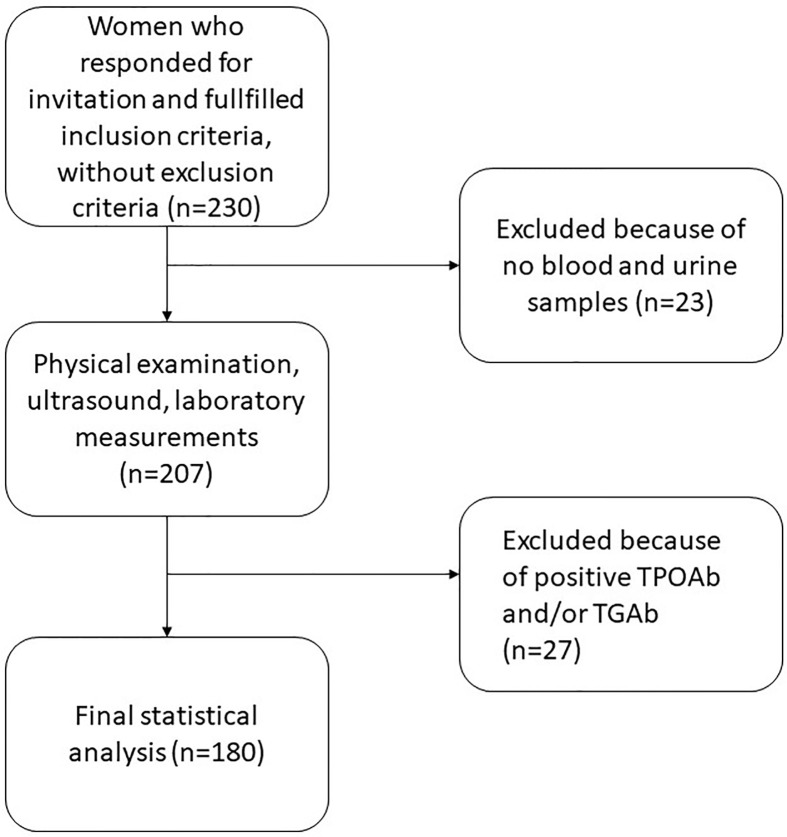
Flowchart diagram for the recruitment for the study. TPOAb, thyroid peroxidase antibodies; TGAb, thyroglobulin antibodies.